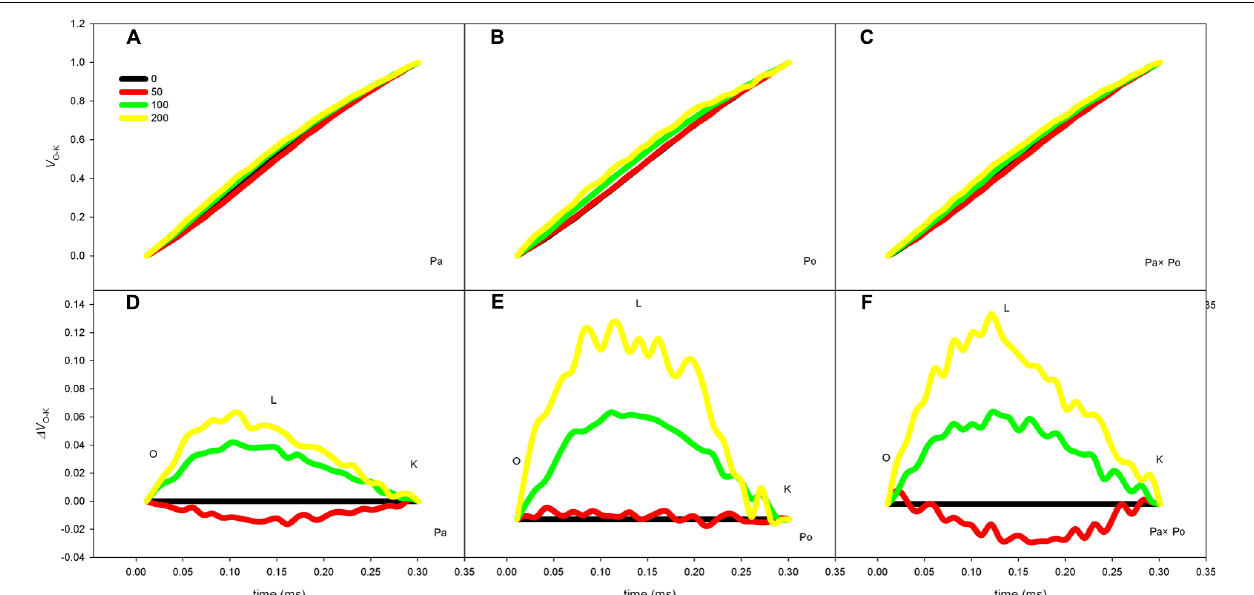
FIGURE 8 | The effect of salt stress on the standardized O–K curves of leaves from three P. amurensis sample groups. The effect of salt stress on the standardized O–K curves of P. amurensis (A,D) . The effect of salt stress on the standardized O–K curves of P. opulifolius “Diabolo” (B,E) . The effect of salt stress on the standardized O–K curves of hybrid P. amurensis (C,F) . Note: Pa, P. amurensis Maxim ( opulifolius “Diabolo” ( ♂